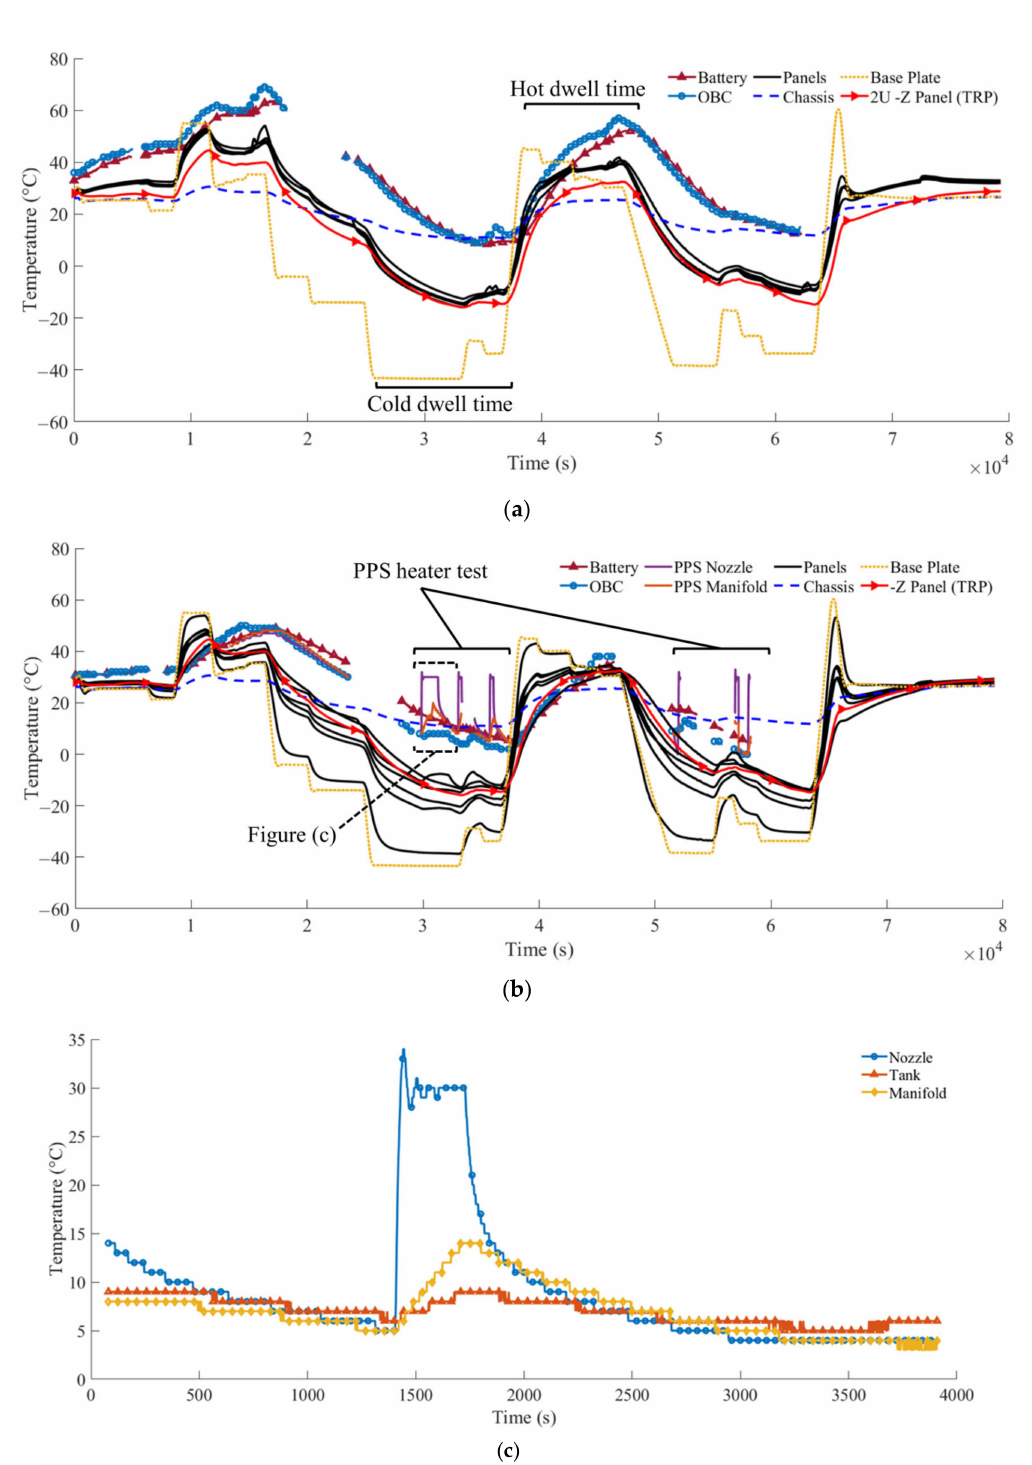
Figure 21. TVCT results: ( a ) Timon temperature profile; ( b ) Pumbaa temperature profile; ( c ) PPS temperature profile of Pumbaa during heater